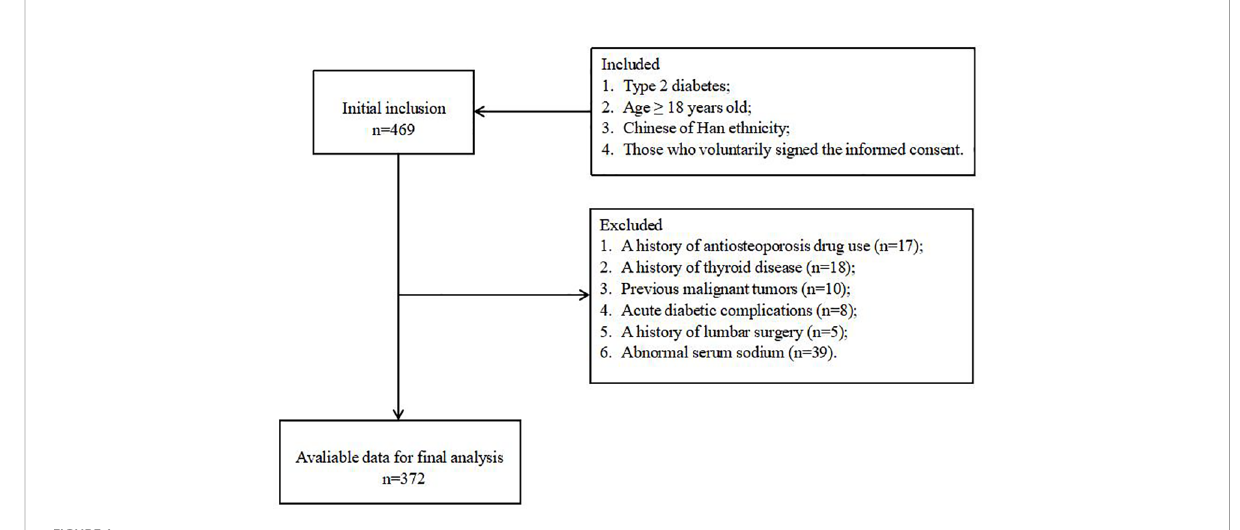
FIGURE 1 The study fl